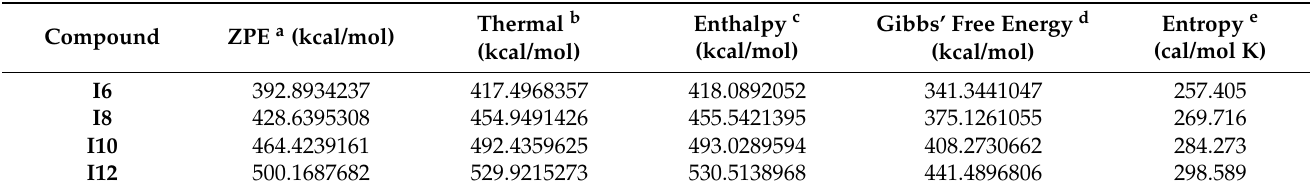
Figure 5. MEP computed for the B3LYP/6-31g(d,p) of series In at the electronic isosurface of 0.02 a.u. Table 3. Zero-point energy, thermal energy and the thermodynamic parameters determined at B3LYP/6-31g(d,p) for group In at 298.15 K and 1